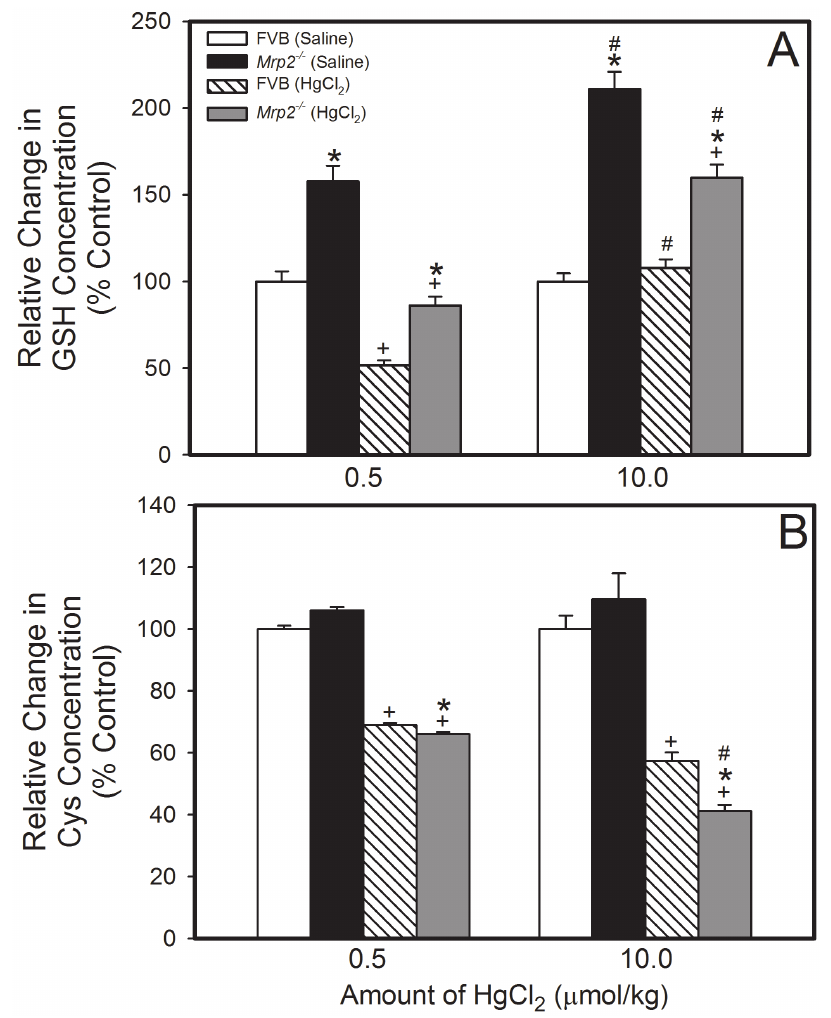
Figure 7. HPLC Analysis of Renal Glutathione and Cysteine Concentration in Mrp2 2 / 2 and FVB Mice. HPLC analyses of renal GSH (A) or cysteine (Cys) (B) were carried out on 3-mm slices of kidneys from Mrp2 2 / 2 and FVB mice exposed to saline, 0.5 m mol ? kg 2 1 ? 8 mL 2 1 , or 10 m mol ? kg 2 1 ? 8 mL 2 1 HgCl 2 . Renal levels of GSH or Cys were normalized to known GSH or Cys standards, respectively. Data represent mean 6 SE of nine samples from three different animals. *, significantly different from the mean of corresponding FVB mice (p , 0.05). + , significantly different from the mean of the same strain of mouse treated with saline (p , 0.05). # , significantly different from the mean of the corresponding group of mice treated with 0.5 m mol kg 2 1 HgCl 2